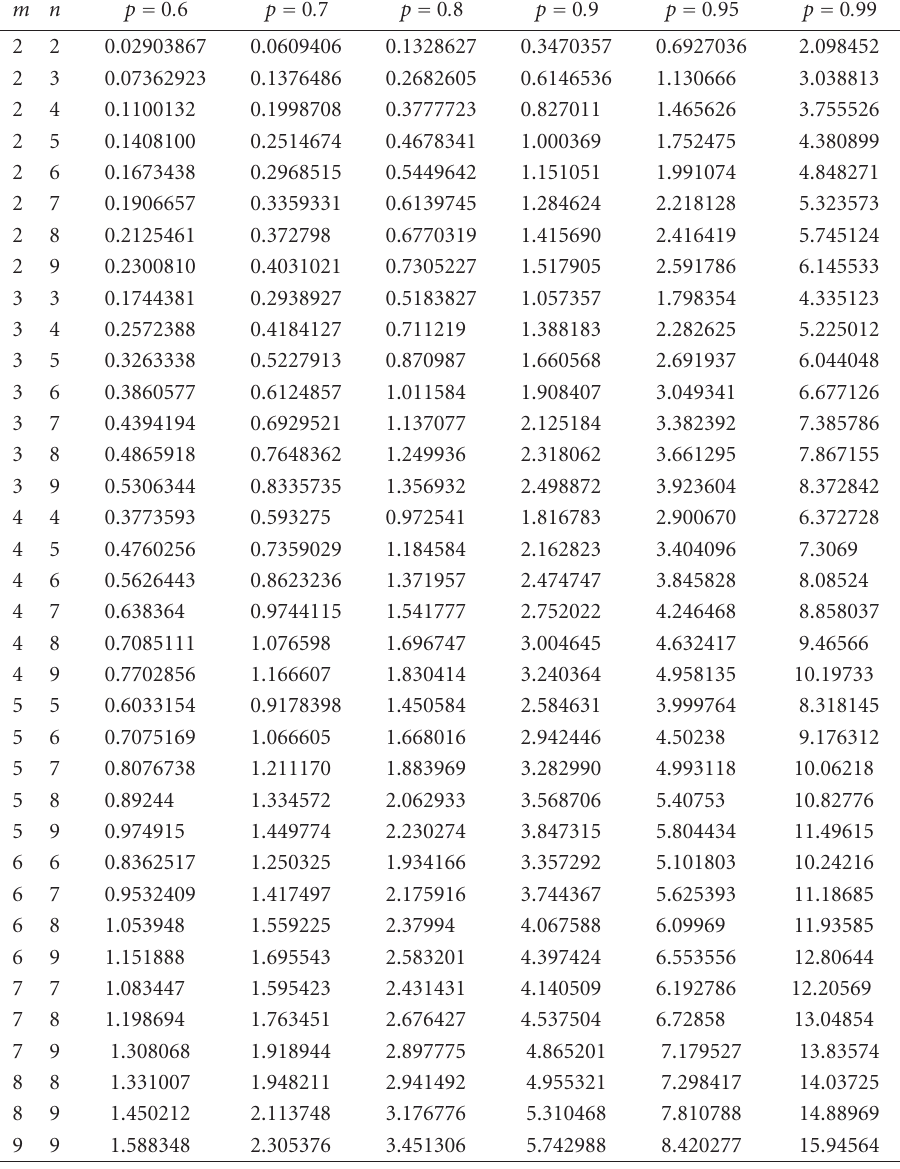
Table 4.1. Percentage points z p of Z = | XY |